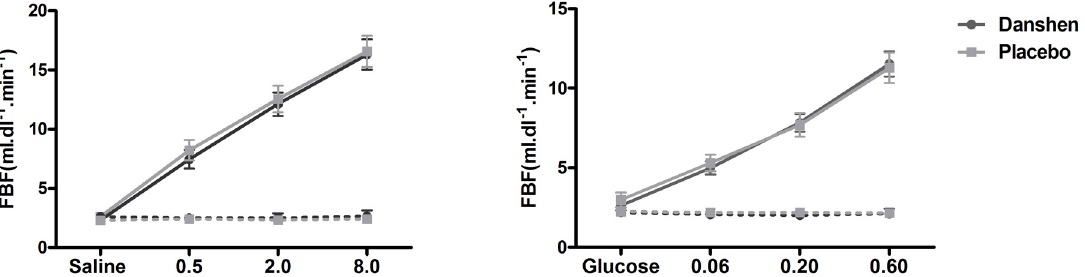
Fig 3. Assessment of endothelial function. Forearm blood flow in response to acetylcholine in the experimental arm (solid lines) and in the non experimental arm (dashed lines) in response to acetylcholine (left panel; dosage 0.5, 2.0, 8.0 μ g.dl -1 .min -1 ) and sodium nitroprusside (right panel; dosage 0.06, 0.20 and 0.60 μ g.dl -1 .min -1 ), during Danshen (dark grey circles) or placebo (light grey